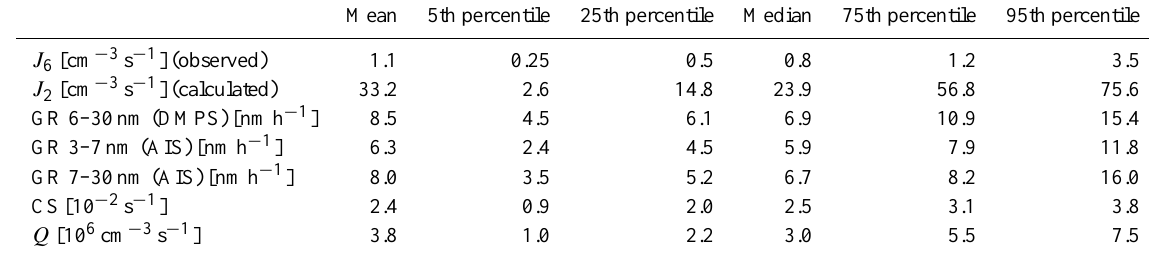
Table 5. Event characteristics.